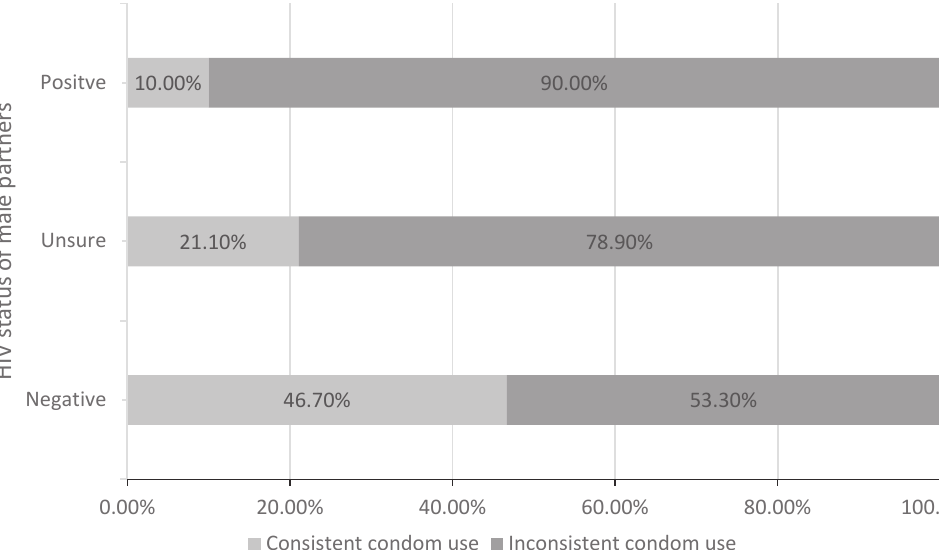
Fig. 3 Inconsistent condom use rate of di ff erent HIV status of male partner ( χ 2 = 6.21, P =